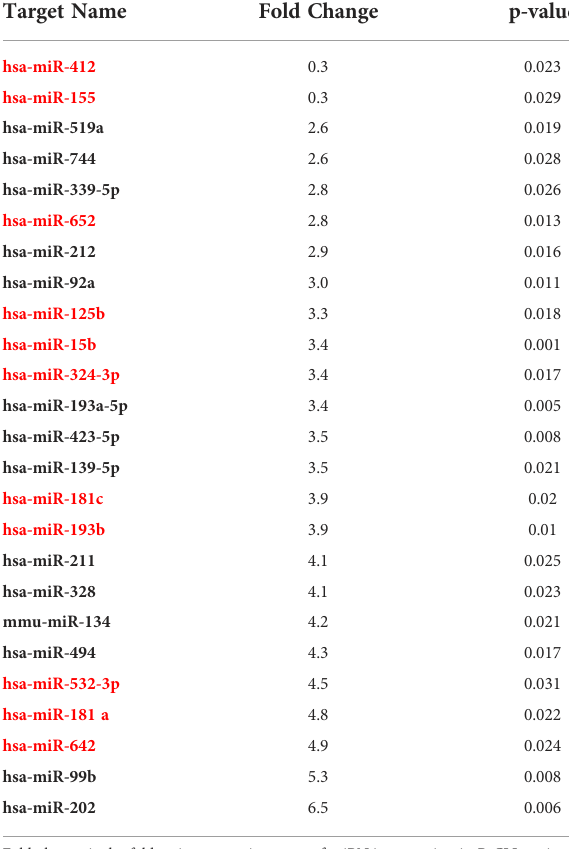
TABLE 2 List of miRNAs signi fi cantly deregulated in responders with BM uMRD versus non responders to fi rst line treatment. Target